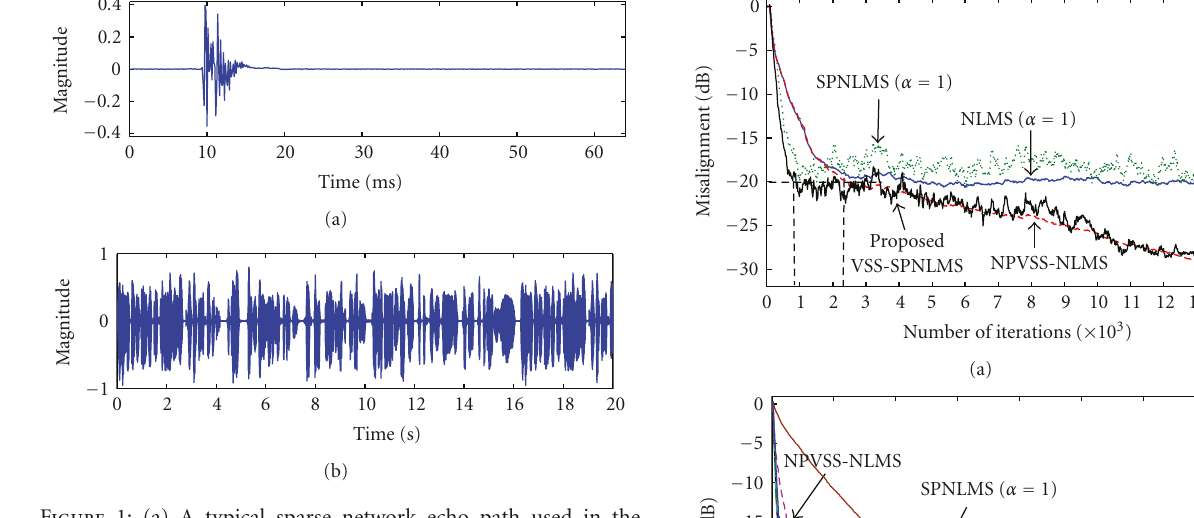
Figure 1: (a) A typical sparse network echo path used in the simulations. (b) A segment of speech signal with 8k sampling rate used in the simulations.